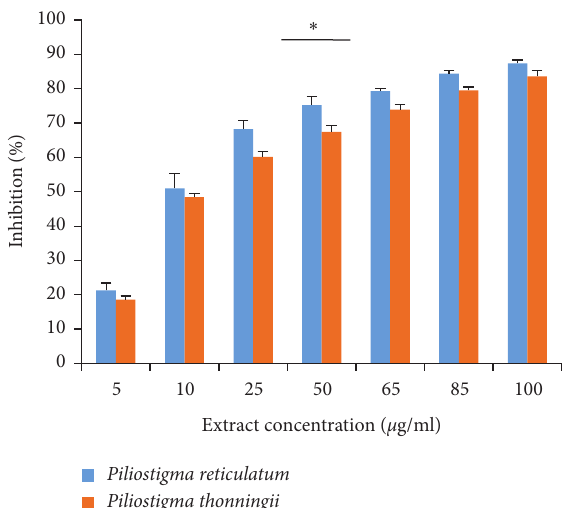
Figure 3: ABTS scavenging ability of P. reticulatum and P. thonningii methanolic leaves extracts. The kinetics of the two extracts is significantly different ( p < 0 . 05).